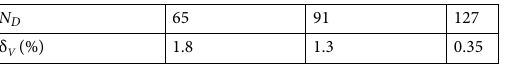
8 . x ) at q = (cid:31)